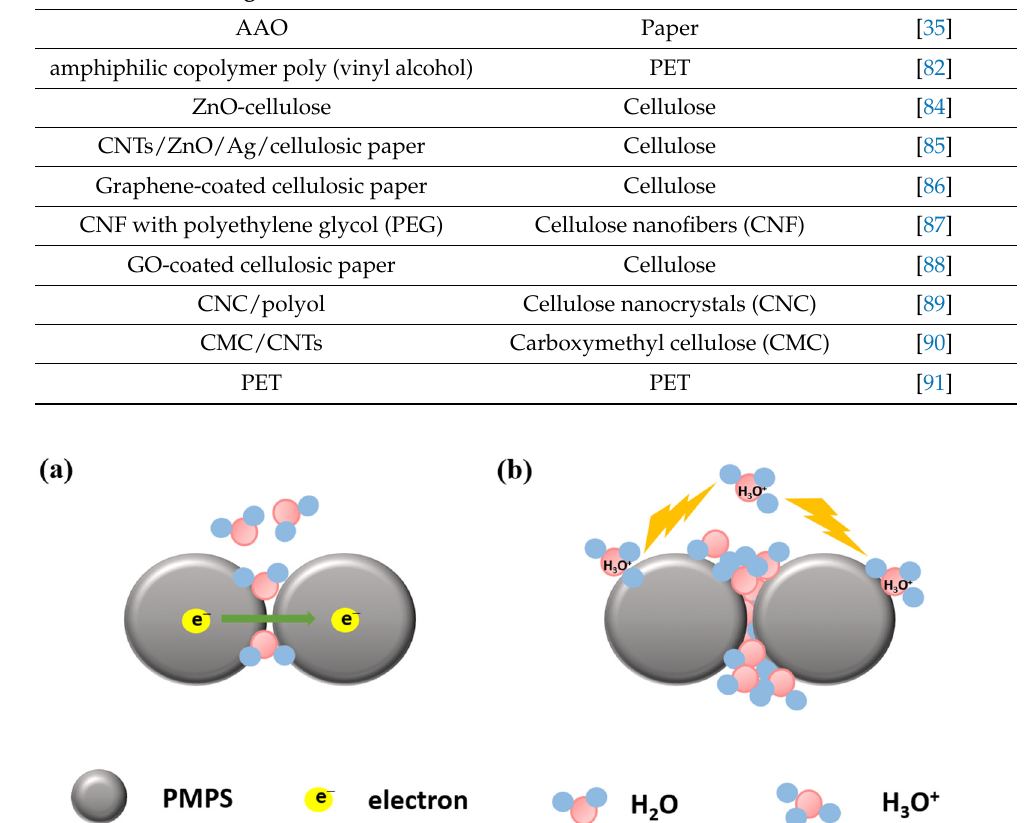
Figure 16. The schematic of polymer humidity-sensing mechanism of PMPS. ( a ) Under low humidity condition and ( b ) high humidity condition.